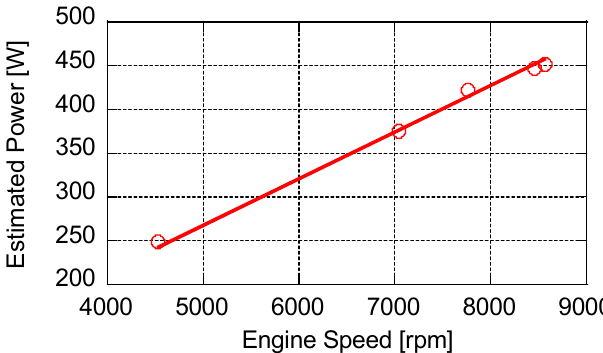
Figure 9. Estimated Saito FG-11 ICE power as a function of engine speed.